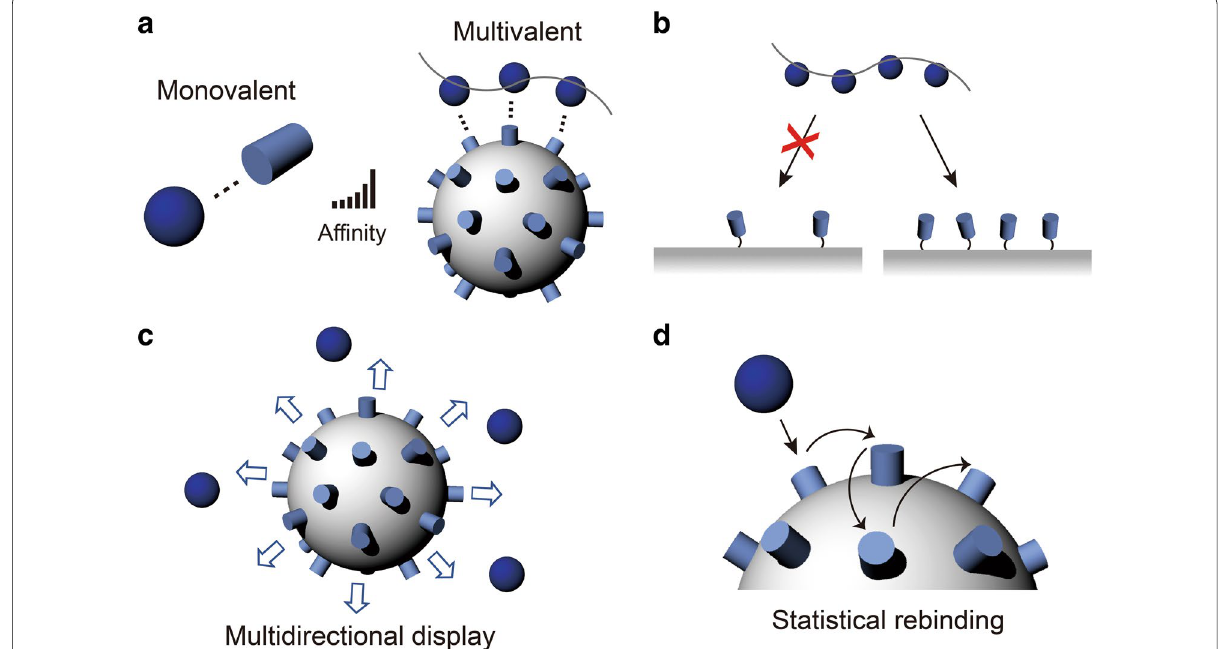
Fig. 2 a Comparison between monovalent‑ and multivalent interactions. b Selectivity in multivalent interactions. c Multidirectional ligand display and d statistical rebinding on a multivalent